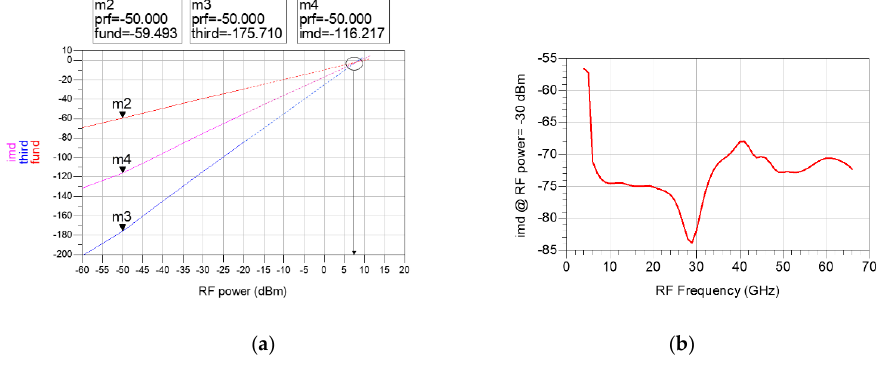
Figure 13. Simulated ( a ) CG versus RF frequency and ( b ) return loss versus frequency of the distrib- uted cascode mixer.